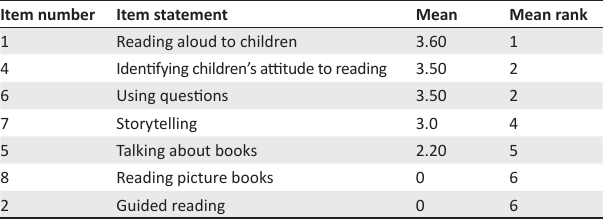
TABLE 5: Mean and mean rank of primary 6 teachers’ frequency of use of reading interest activities. Item number Item